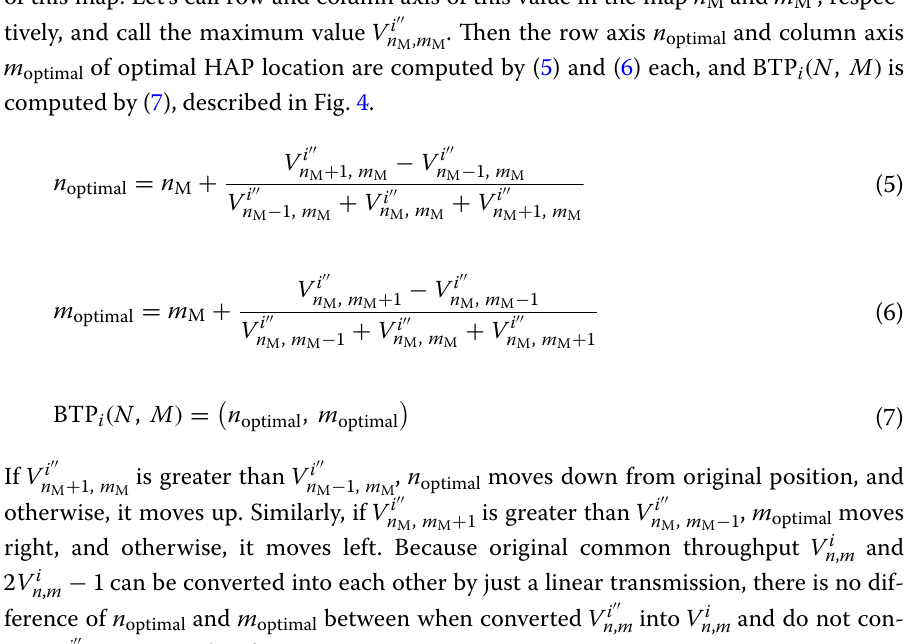
n optimal , m optimal = (cid:31)